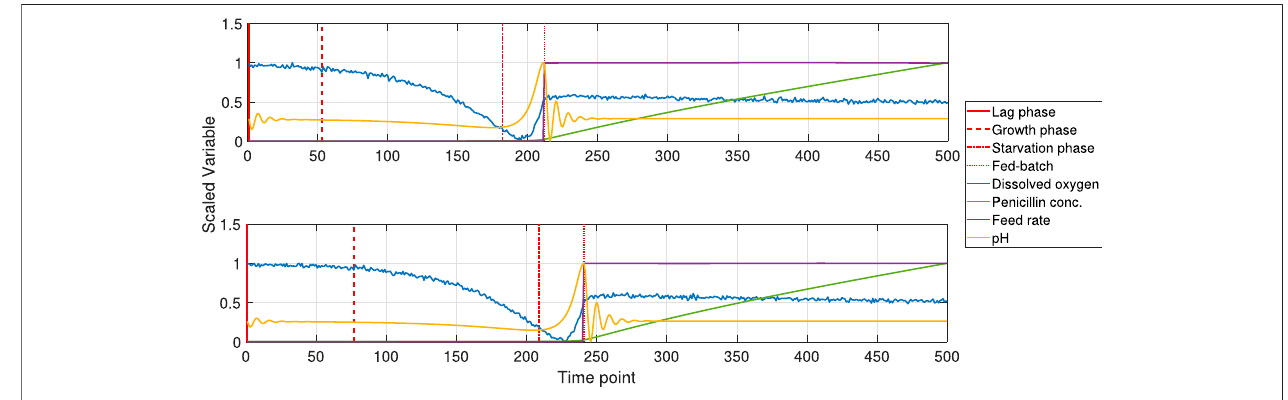
FIGURE 10 | Overlay plot for two batches of Pensim with the identi fi ed